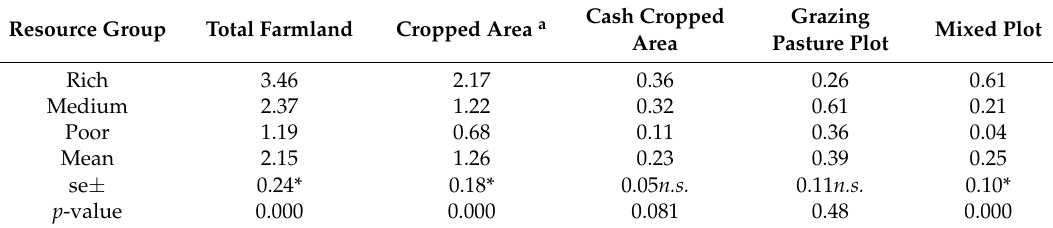
Table 1b. Land allocation (in ha) for different